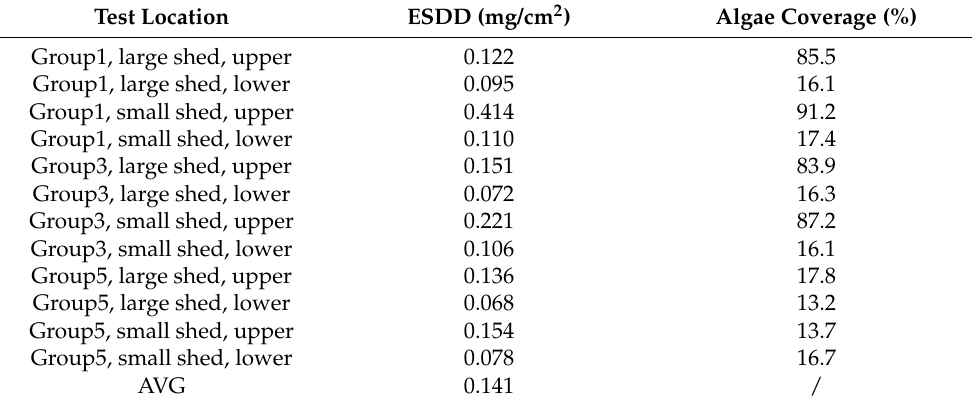
Table 6. The results of the contamination level measurements.